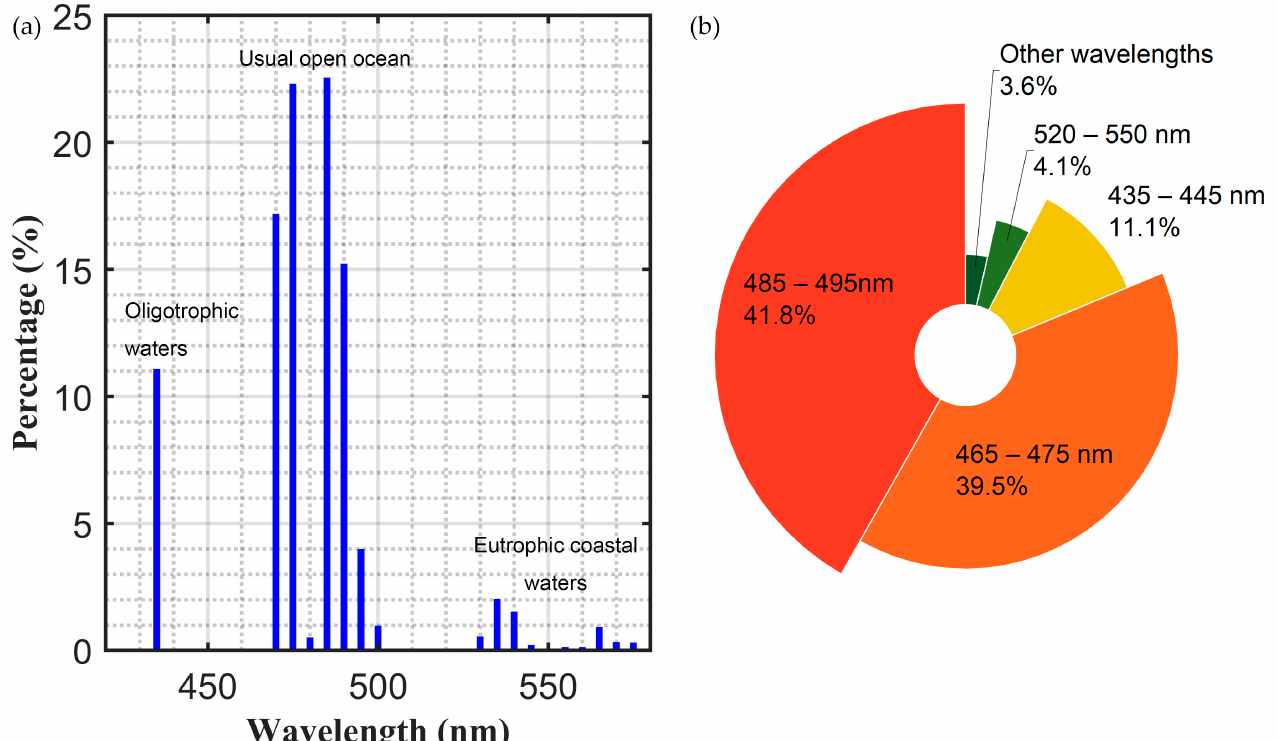
Figure 12. Statistical distribution of optimal laser wavelengths. ( a ) Area percentage bar for each wavelength and ( b ) area percentage pie plot for each wavelength range.